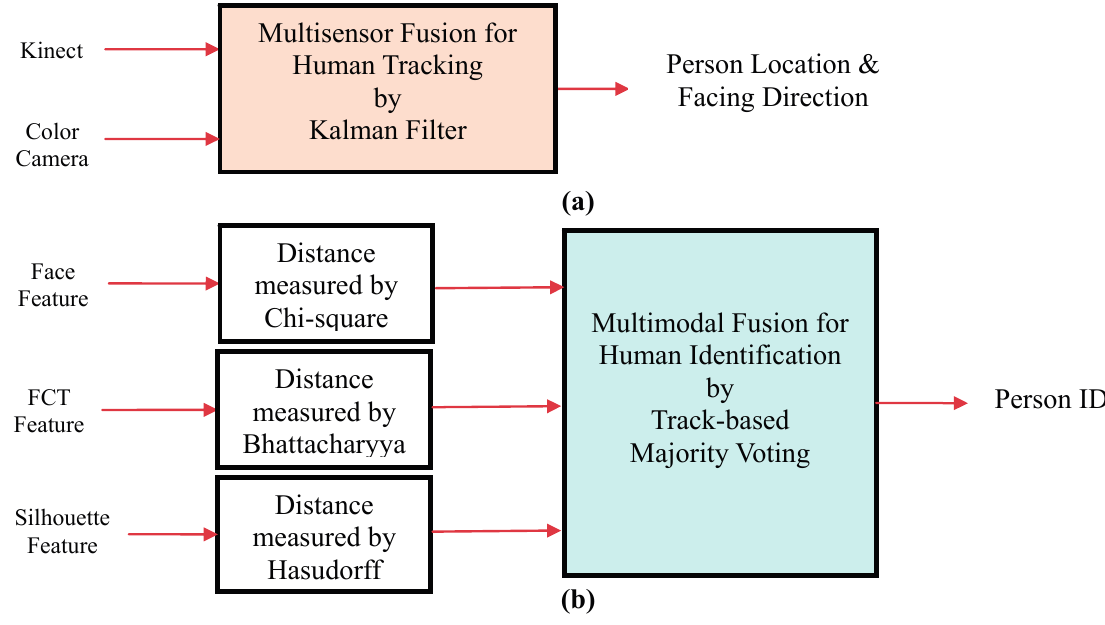
Figure 5. Two data fusion approaches in the proposed system: ( a ) multisensor fusion for human tracking; ( b ) multimodal fusion for human